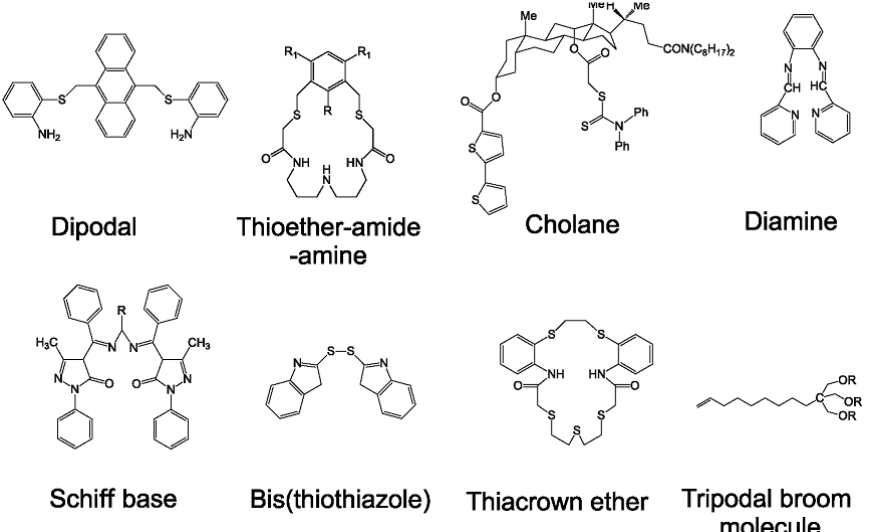
Figure 2. The depiction of the structures of some compounds commonly used as silver ionophores based on data given in paper [1].